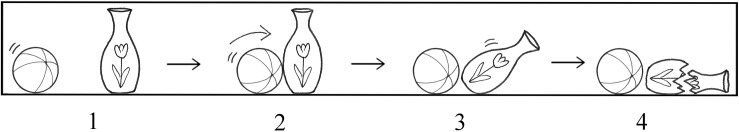
Example of a series of sub-events within a video event in the elicitation experiment. Each video event are 4 s long and the series of sub-events occur without any pauses. The figure illustrates the video event involving a ball and a vase: (1) The ball rolls, (2) hits the vase, (3) the vase tips over, and (4) the vase breaks. As shown, the sequence from one sub-event to the next involves causal and temporal relations. Each sub-event involves movement, contact with another object, or change of state/location.